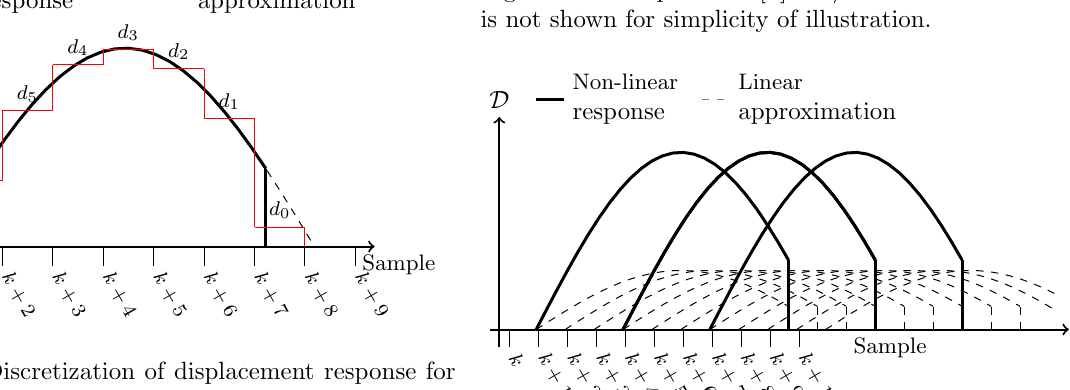
Figure 12: Discretization of displacement response for a motoring stroke.